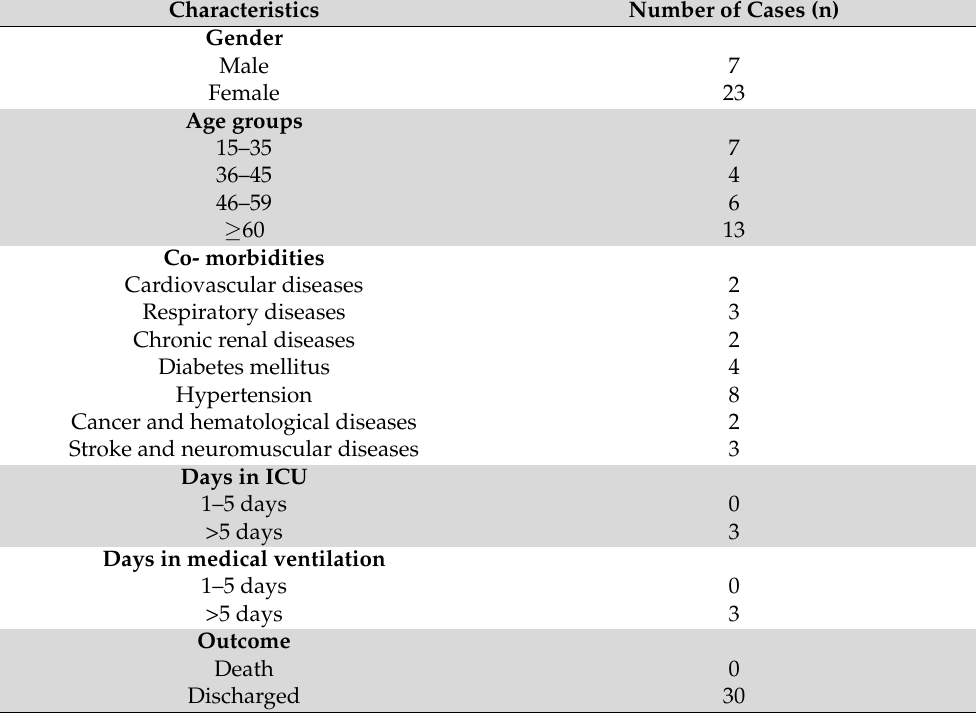
Table 1. Clinical characteristics of influenza associated hospitalization during 2018–2019 season (n =